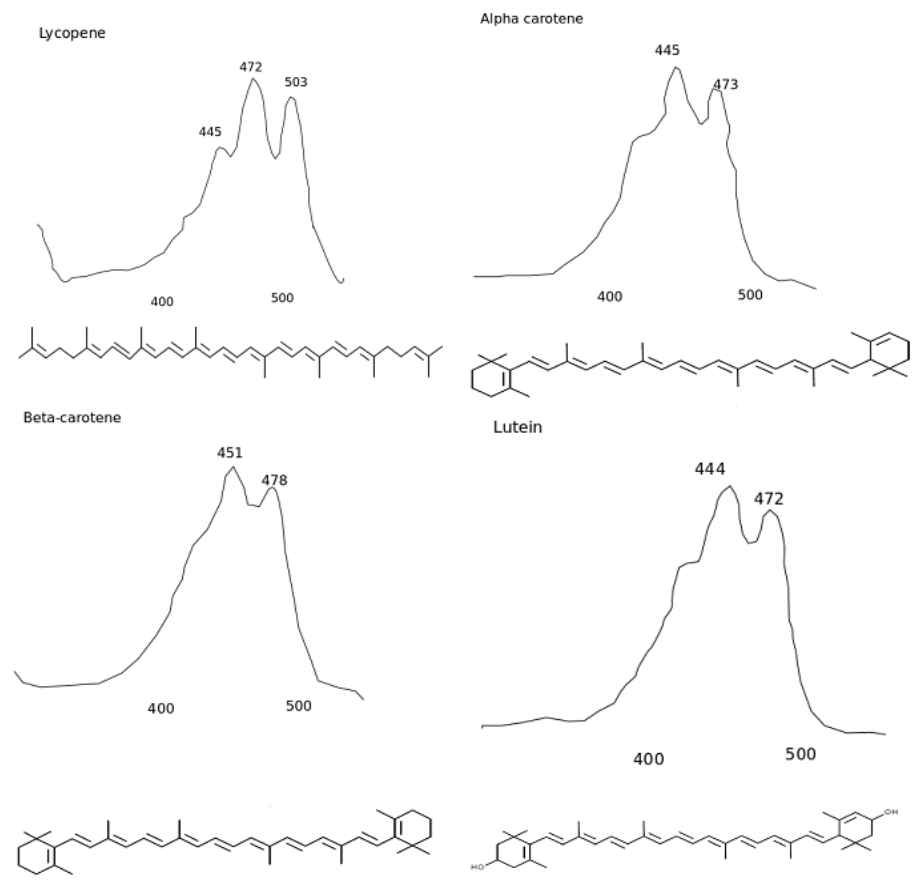
Figure 3. Chemical and molecular structures of selected carotenoids from Zielinska et al. [34].